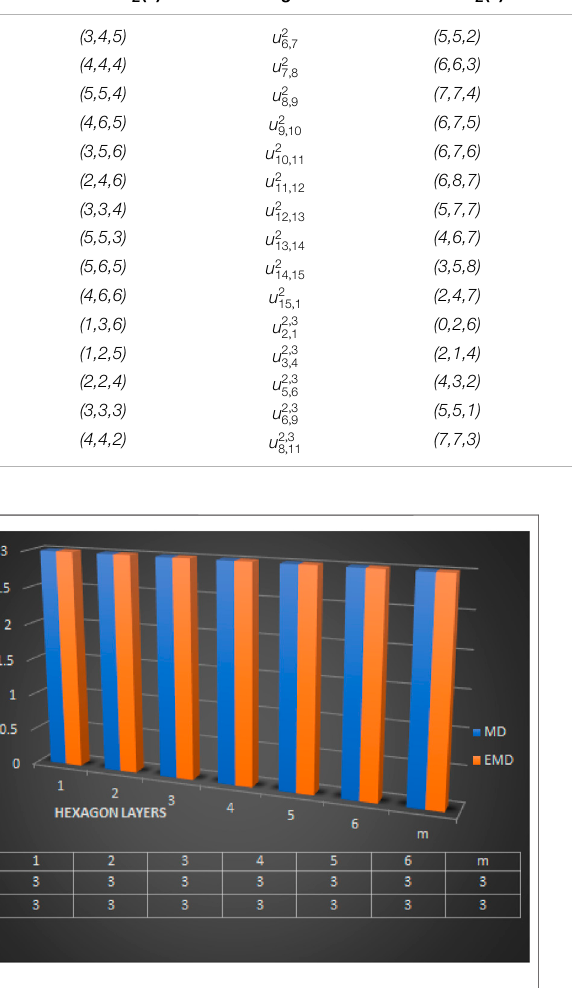
FIGURE 8 | Comparision between MD and EMD of CNC 5